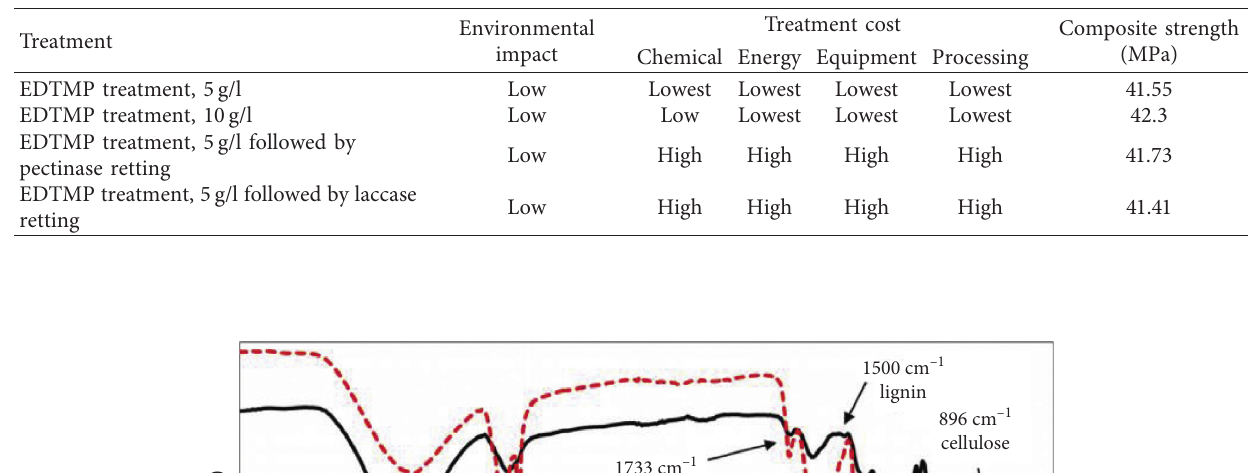
Table 7: Relative environmental, economic, and strength performance for the chelator, combined chelator, and enzyme-treated hemp- reinforced polypropylene composite